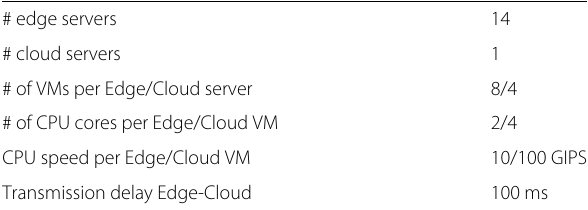
Table 5 Edge infrastructure simulation parameters as in